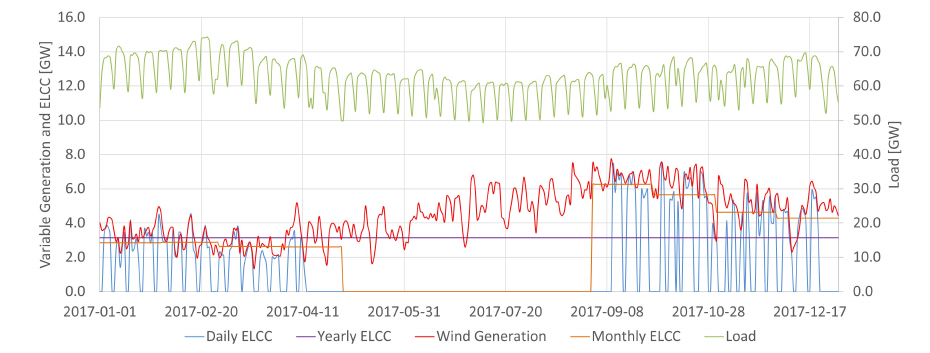
Figure 4. Daily, monthly and yearly ELCC for wind power in 2017 for the SIN.